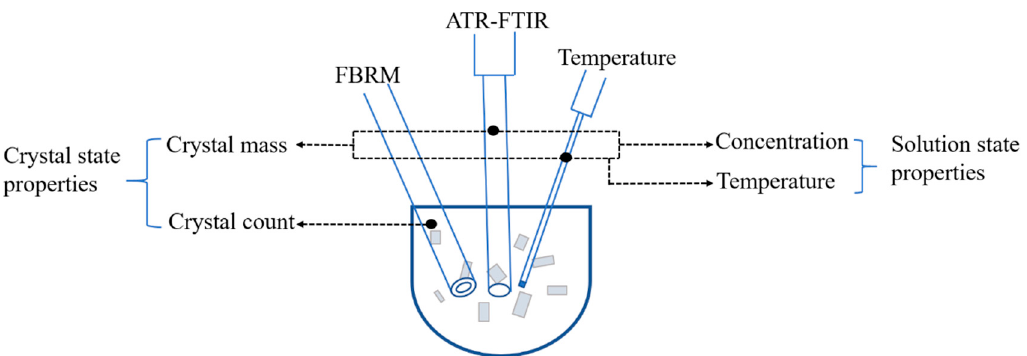
Figure 11. Measurements made online with PAT instruments.